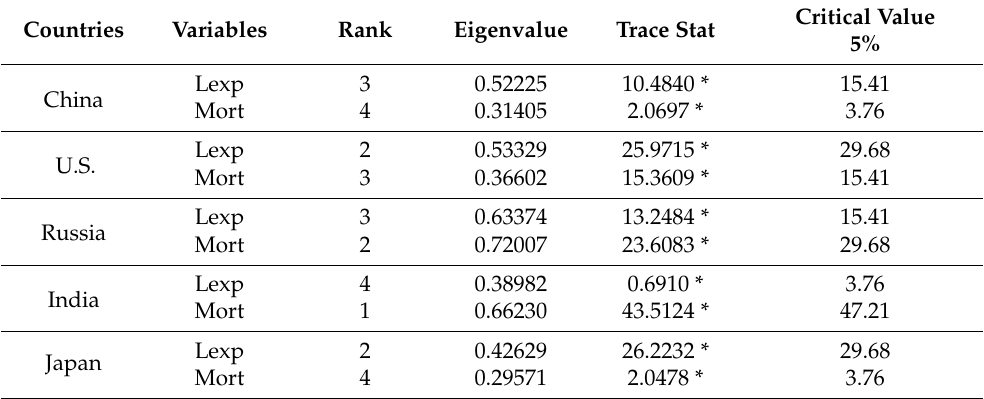
Table 8. Eigenvalue table for all five countries. Countries